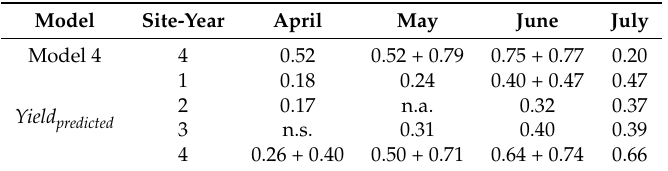
Table 8 highlights the corresponding correlations for Model 4 of site-year 4 and for the new model Yield predicted , employed to the data sets of all site-years. Table 8. Adj. r 2 values of Model 4 and model Yield predicted for the corresponding FS indices and MP signal, grouped by months and site-years. n.a. = not available, n.s. = not significant. p -values for Model 4 < 0.05. p -values for Yield predicted <